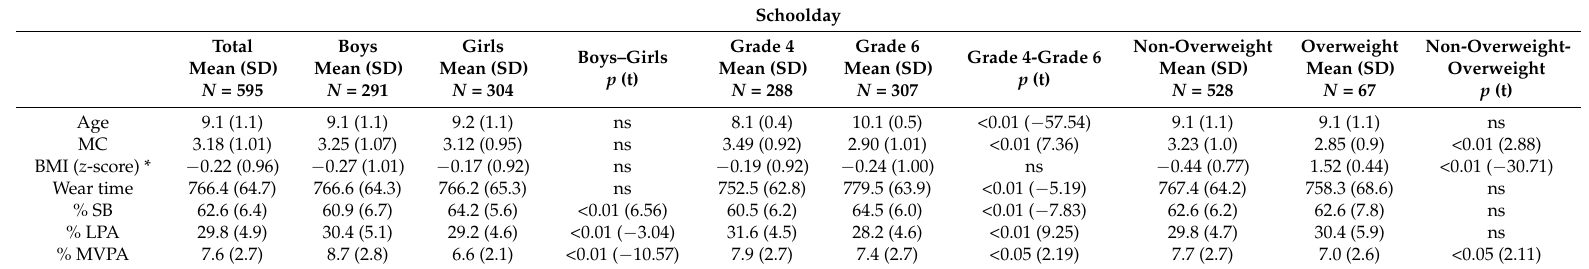
Table 1. Descriptive characteristics (mean and standard deviation); total and stratified by gender and grade.